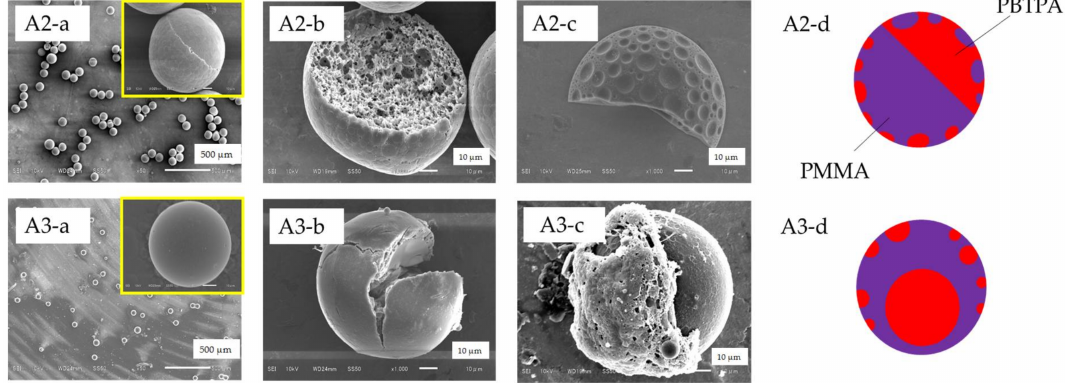
Figure 3. SEM images of microspheres of PBTPA/PMMA prepared with the conditions listed in Table 1 (A2 and A3), ( a ) as-prepared, ( b ) cracked, ( c ) after soaking with acetone, ( d ) schematic